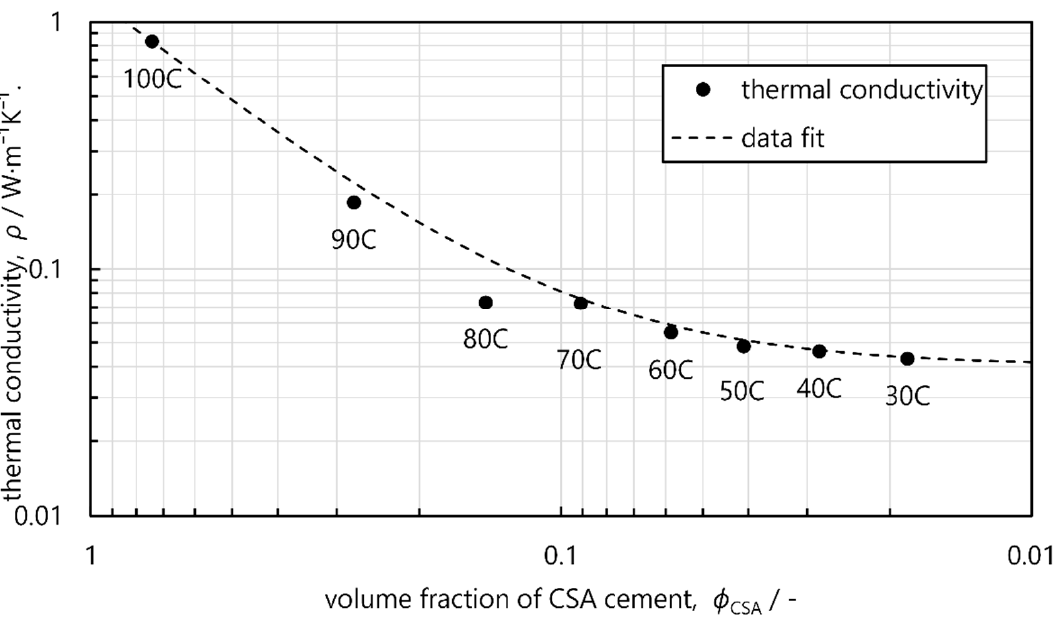
Figure 8. Thermal conductivity as a function of the cement content using surface probes. For each sample composition, a large prism ( N = 1) was measured at three different spots ( S = 3). Data fit to f( ϕ ) = a 0 + a · ϕ v , with a 0 = 0.0404, a = 1.234, and υ = 1.48.